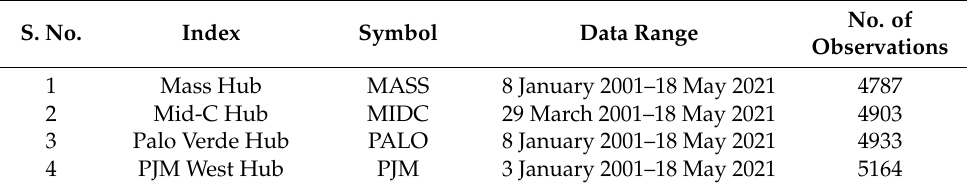
Table 1. Description of indices, symbols, and data range.